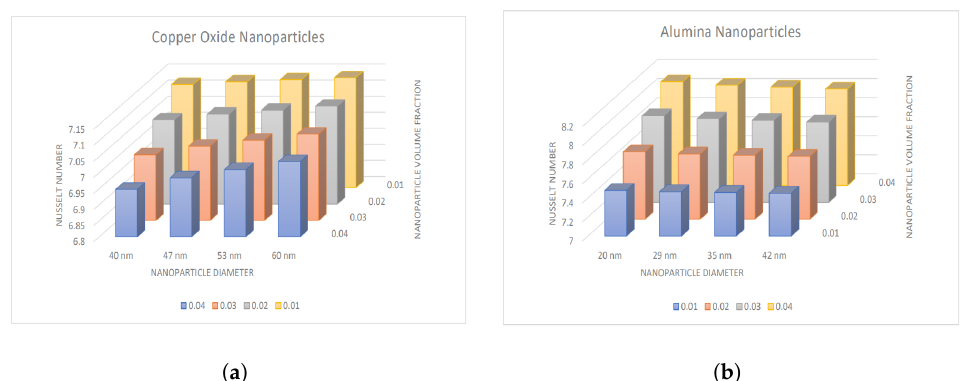
Figure 7. Variation in Nusselt number with nanoparticle diameter and volume fraction for ( a ) CuO- nanoparticles, ( b ) Al 2 O 3